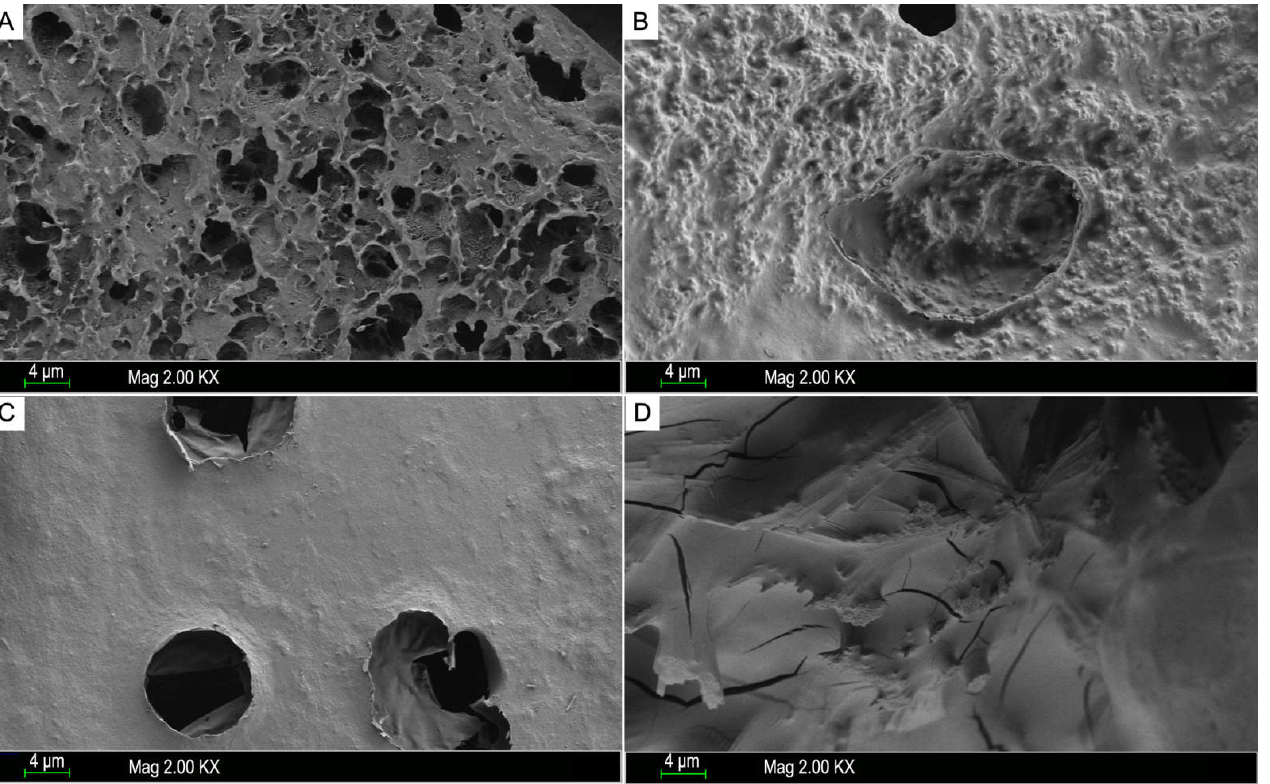
Figure 4. SEM images of the purified fractions LJP0 ( A ), LJP04 ( B ), LJP06 ( C ), and LJP08 ( D ). The magnification is 2 kX, and the scale bar is 4 μm.